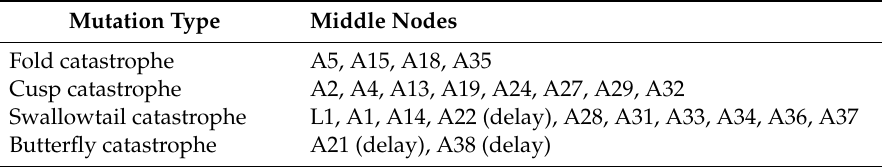
Table 4. Middle nodes involved in each type of